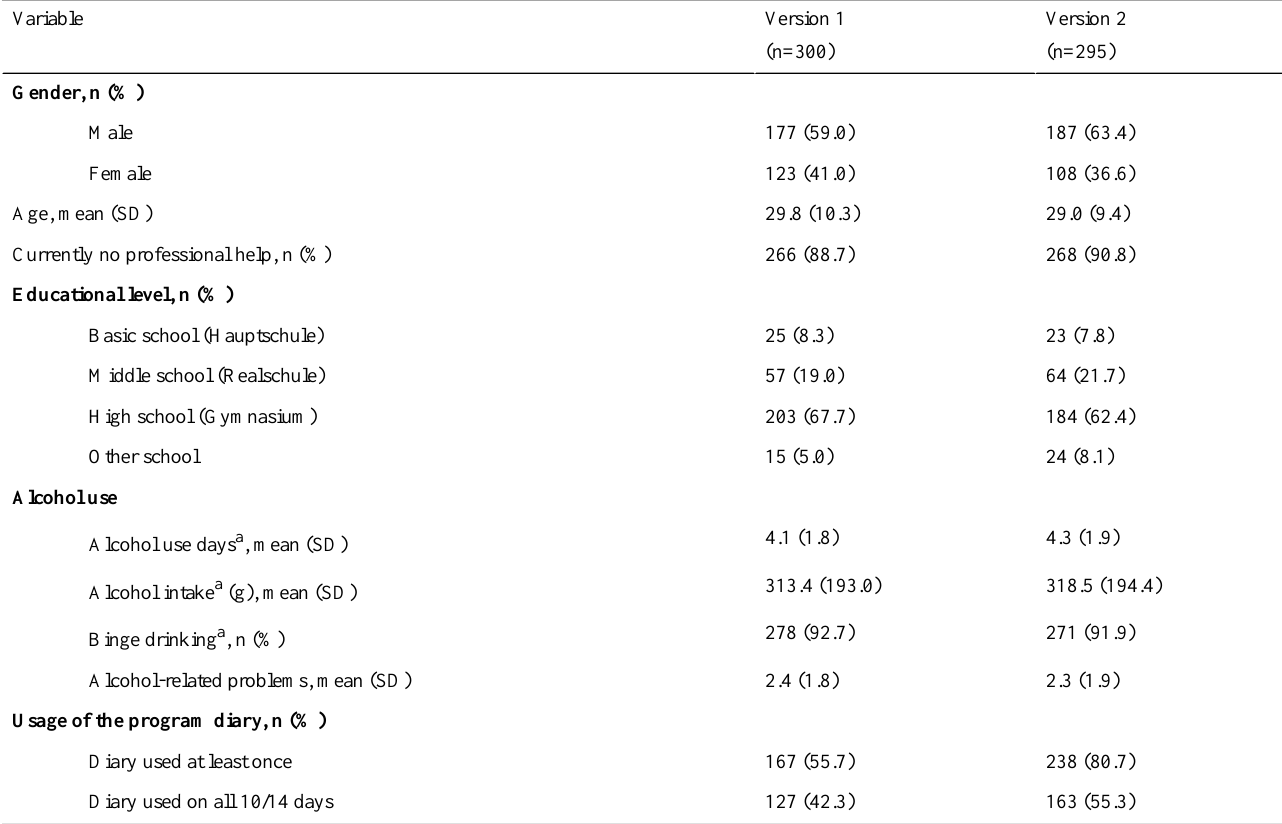
Table 2. Participants’characteristics at baseline and usage of the Change Your Drinking program (N=595).